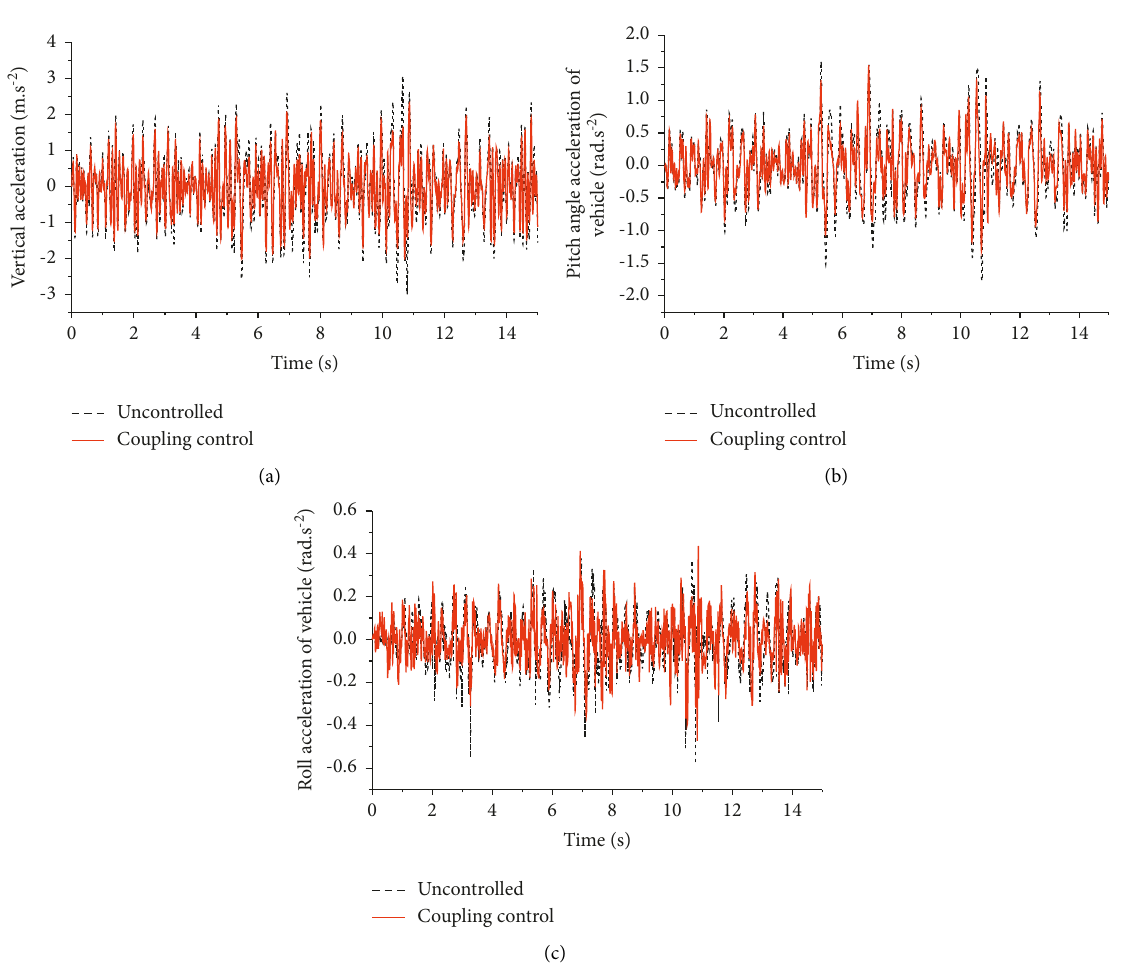
Figure 11: Ride comfort control result under angle step condition. (a) Vertical acceleration of vehicle. (b) Pitch angle acceleration of vehicle. (c) Roll acceleration of